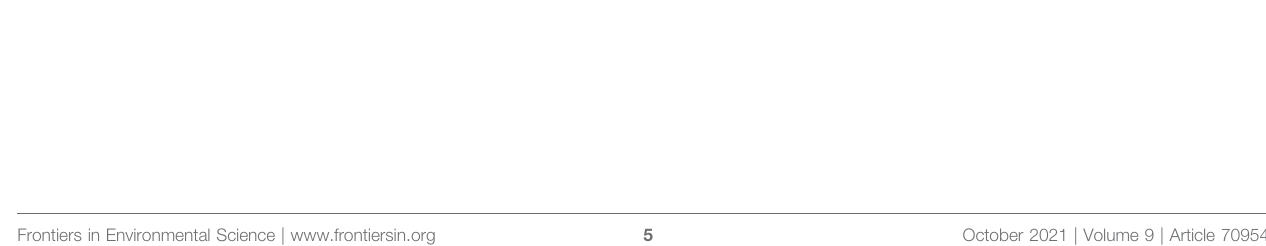
Frontiers in Environmental Science |